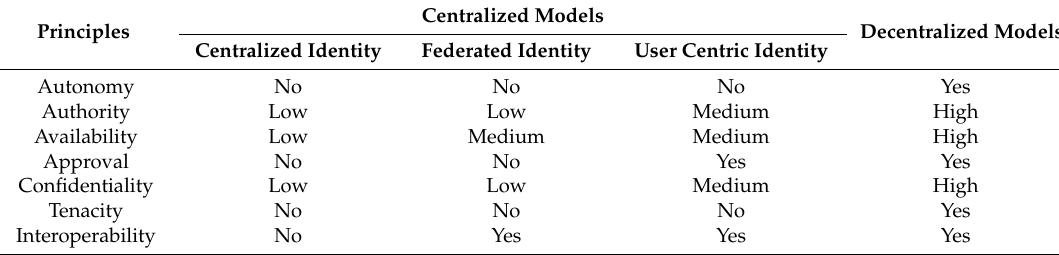
Table 2. Identity management (IdM) models